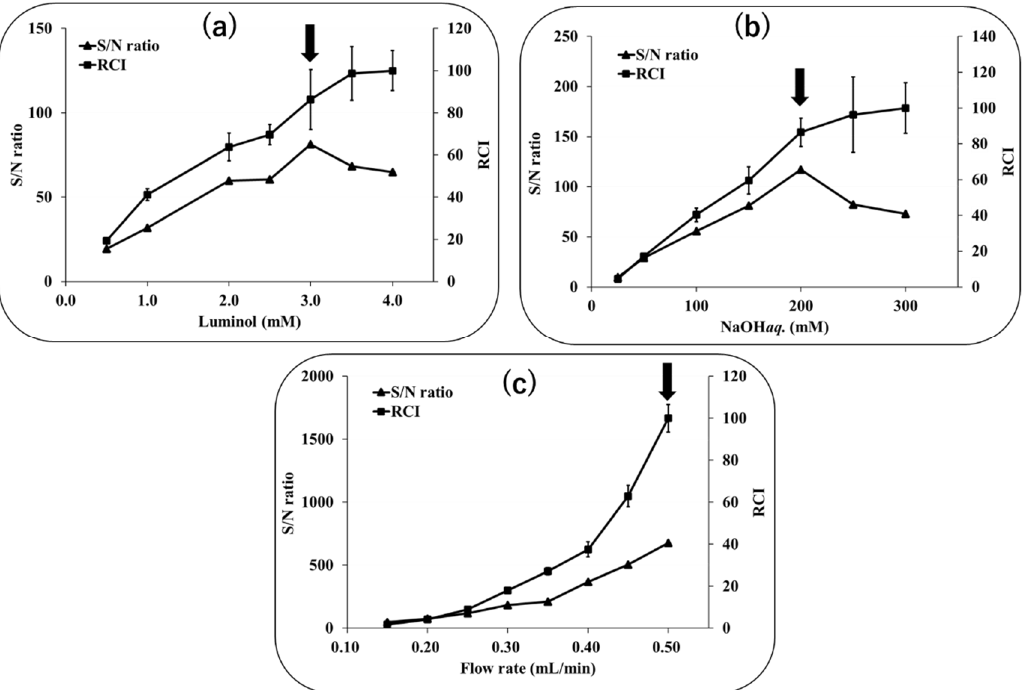
Figure 7. The effects of different factors affecting the online reduction column—luminol CL system for UQ, including ( a ) luminol concentration, ( b ) luminol solvent (NaOH aq . concentration), and ( c ) luminol flow rate, on relative chemiluminescence intensity (RCI) and signal to noise (S/N ratio. The arrows indicate S/N ratio maximum.